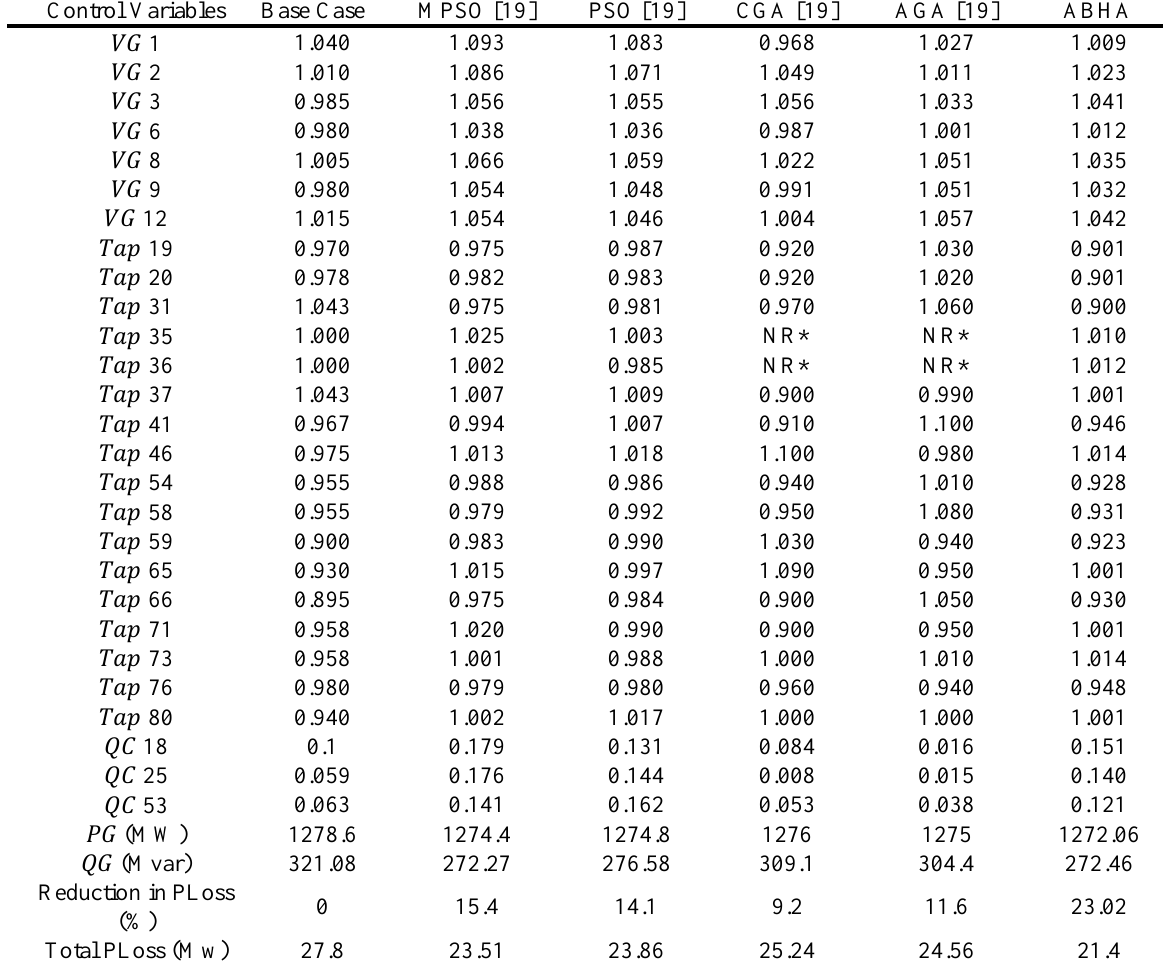
Table 9. Simulation results of IEEE −57